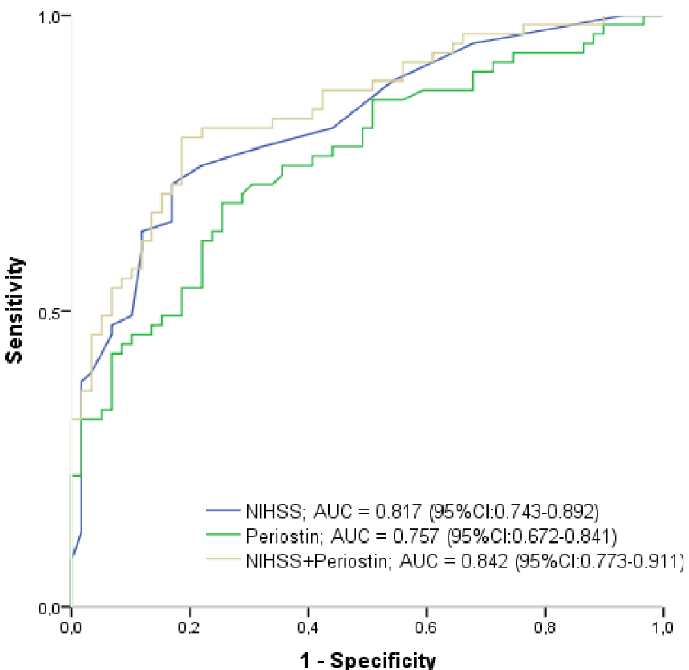
Figure 3. Receiver operating characteristic curve analysis of prognostic predictive ability of serum NIHSS score on admission, serum level of periostin on admission and the combination of NIHSS score and periostin for 3-month unfavorable outcome in patients with acute ischemic stroke. AUC, area under the curve; CI, confidence interval; NIHSS, National Institute of Health Stroke Scale.